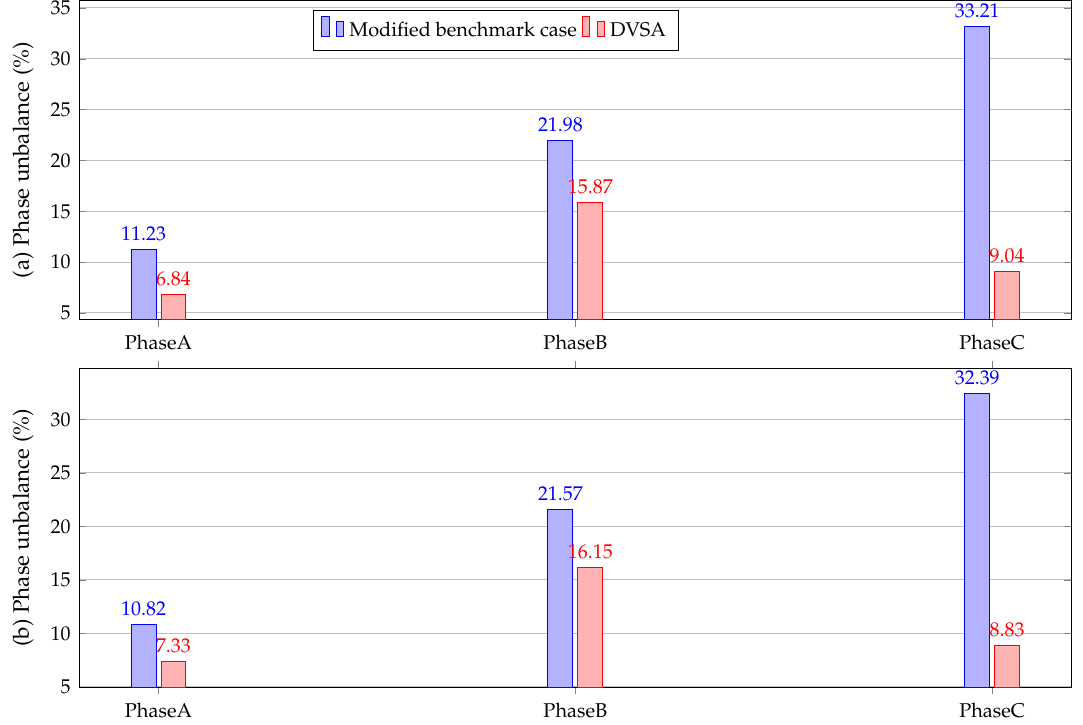
Figure 16. Unbalanced percentage of the 37-node test system: ( a ) active power and ( b ) reactive power.